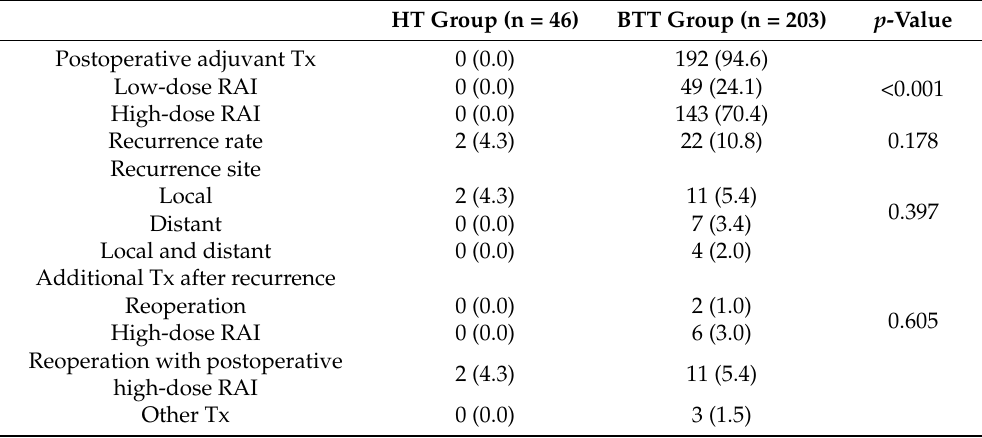
Table 4. Comparison of postoperative additional treatment and recurrence between patients who underwent HT and BTT.